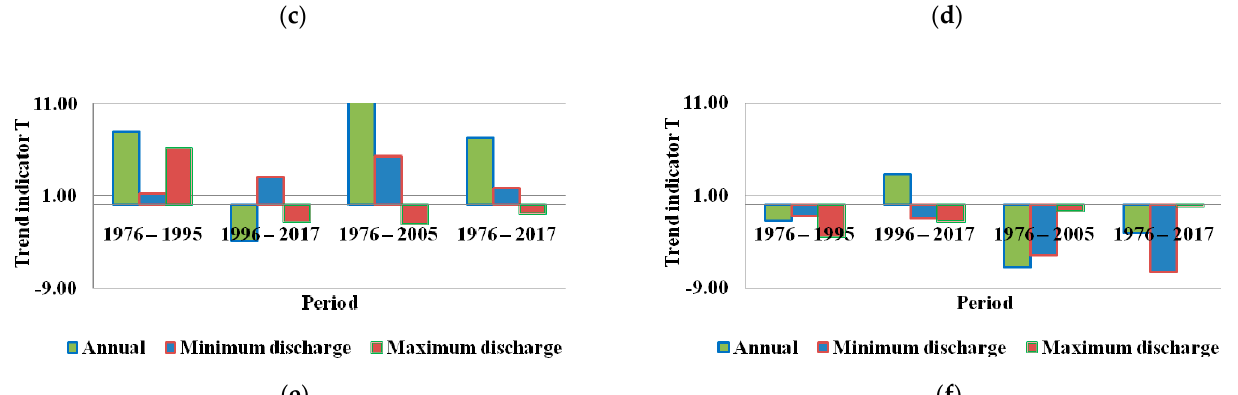
Figure 6. Trend analysis using the ITA method for different time steps (season, monthly, annual, and max and min) according to the four study periods for Skhira ( a , c , e ) and Haffouz ( b , d , f ).